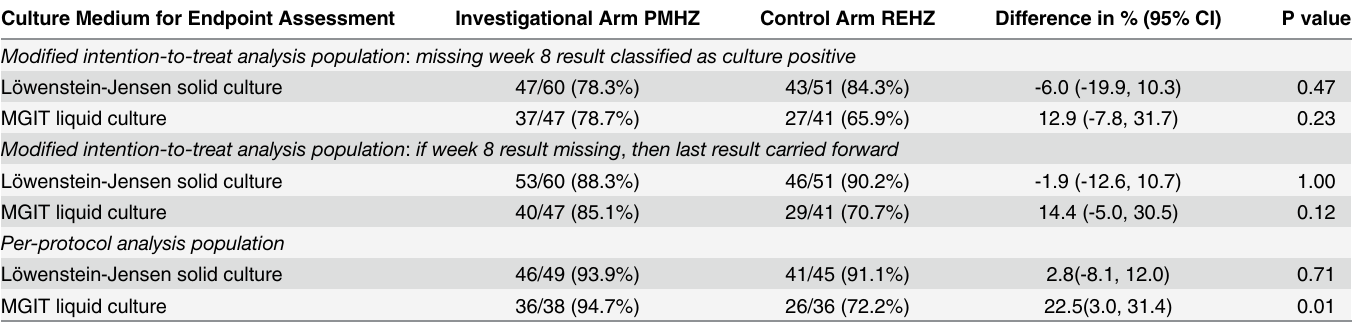
Table 2. Proportions of participants with negative cultures at completion of intensive phase treatment. Abbreviation: CI, confidence interval; MGIT, Mycobacterial Growth Indicator